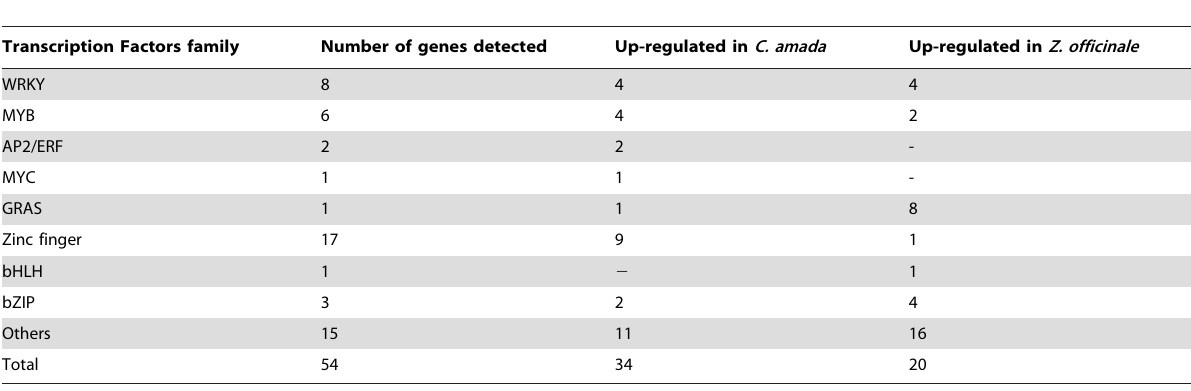
Table 4. Summary of transcription factor unigenes of C. amada and Z. officinale.